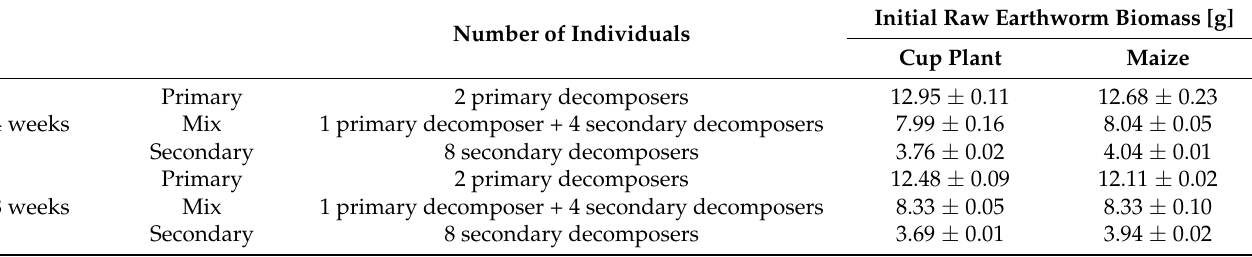
Table 2. Initial raw earthworm biomass [g] (means ± SE, n = 5) and individuals per replicate for cup plant and maize treatments for incubations of 4 and 8 weeks. Earthworm treatments: primary = primary decomposer L. terrestris ; secondary = secondary decomposers A. caliginosa and A. rosea ; mix = primary and secondary decomposers. Initial Raw Earthworm Biomass [g] Number of Individuals Cup Plant